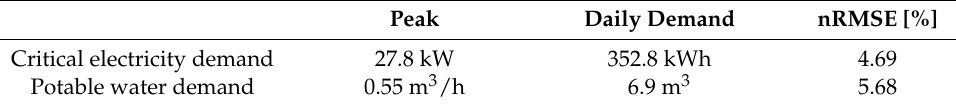
Figure 7. Critical electricity demand and potable water demand profiles employed in this study. Table 2. Characteristics of demand